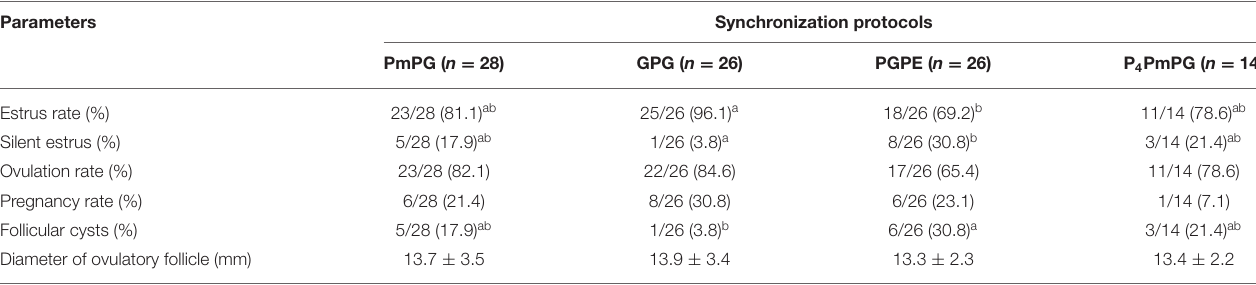
TABLE 1 | Fertility parameters of crossbred buffaloes synchronized using PmPG, GPG, PGPE, and P 4 PmPG protocols during breeding season. Parameters